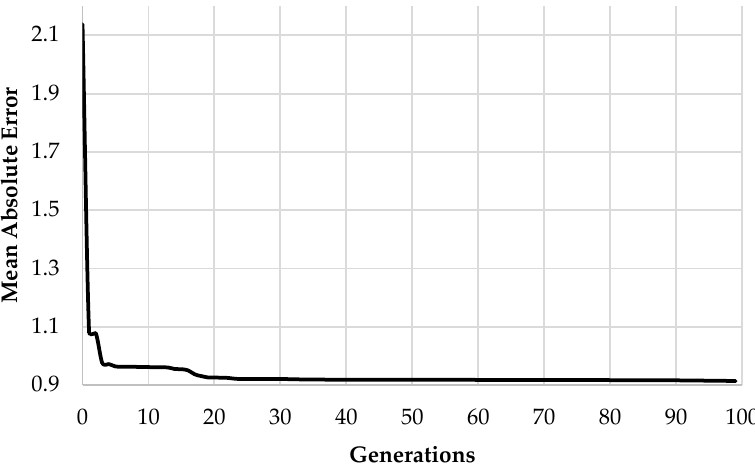
Figure 7. Convergence of the genetic algorithm optimization model.